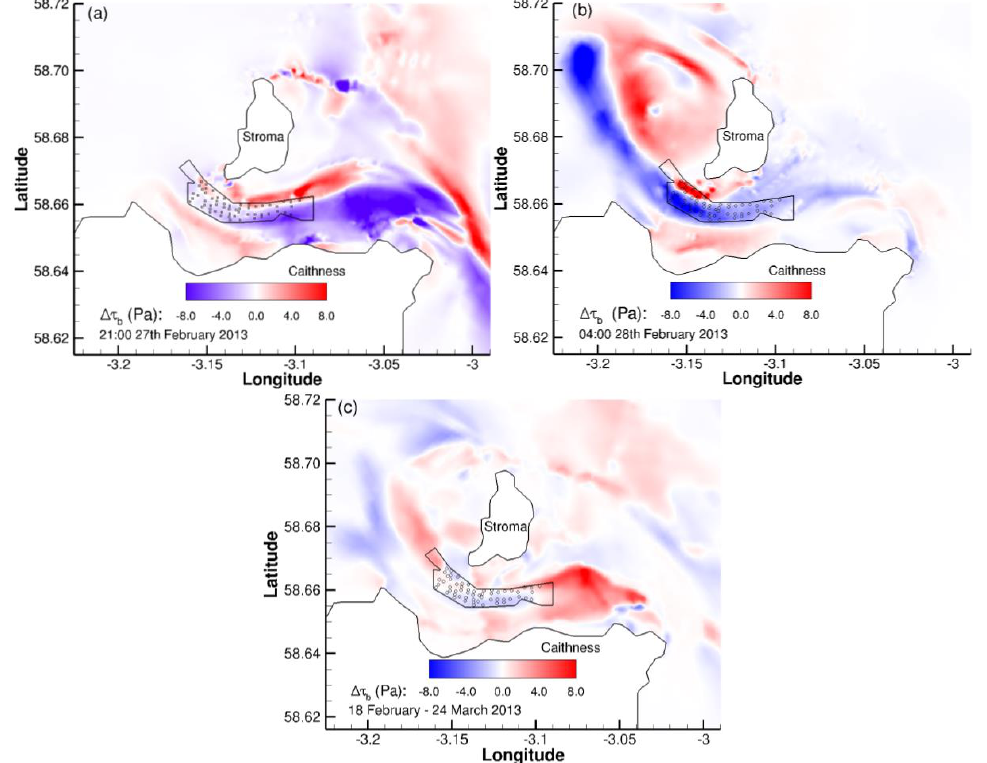
Figure 9. The modelled effect of 57 turbines on bed shear stress (Δ τ b , Pa) at ( a ) spring tide flood and ( b ) spring tide ebb, in the Inner Sound on 27–28 February 2013. Δ τ b is the difference in bed stress between the simulations with no turbines (Run 1) and with 57 turbines (Run 7). Positive values indicate an increase in shear bed stress with turbines; negative values indicate that the stress is reduced with the turbines in place. The difference in the maximum bed stress that occurs at each model location over the whole simulation (i.e., not necessarily contemporaneously) between the two simulations is also shown ( c ). Tidal turbine locations (o) and the lease area (―) are indicated.